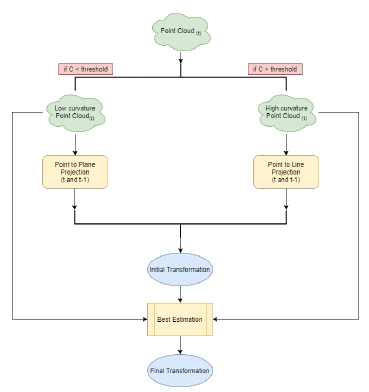
Figure 3. Flowchart of Initial motion